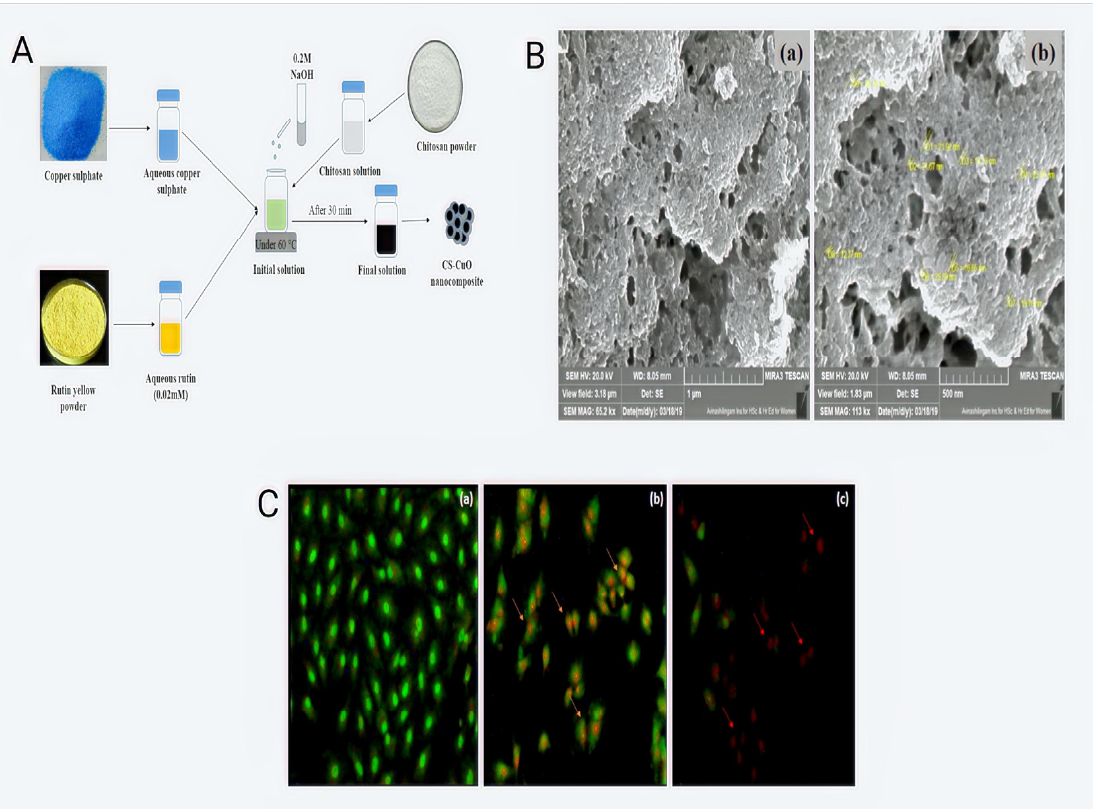
Figure 2. Anti-proliferative activity of chitosan/copper oxide nanocomposites containing rutin in human lung cancer cells; a systematic depiction of bio-inspired synthesis: ( A ) synthesis of the CS-CuO-rutin nanocomposite, ( B ) FE-SEM study, ( a ) CS-CuO nanocomposite at 65.2 kx magnifications ( b ) CS-CuO nanocomposite at 113 kx magnifications ( C ) apoptosis study in A549 cells using the AO/EtBr dual staining method. A549 cells that are untreated and display a green hue are alive, while orange and red hues suggest early cell death for rutin and late cell death for the CS-CuO nanocomposite ( a ) control cells, ( b ) rutin treated and ( c ) CS-CuO nanocomposite treated [58].